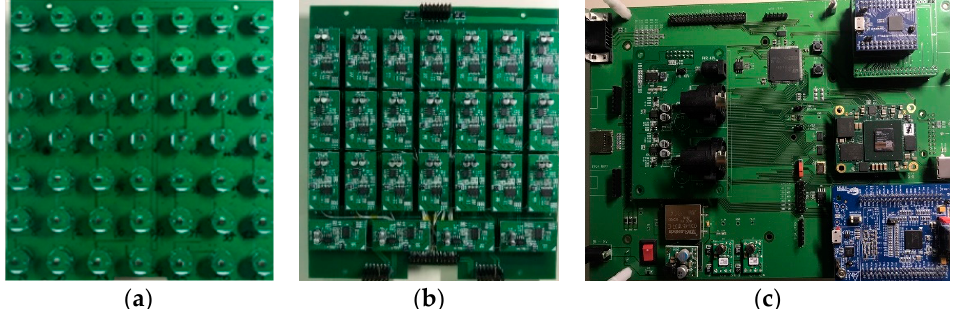
Figure 5. Implementation of the two-dimensional (2D) microelectromechanical system (MEMS) microphone array and the processor: ( a ) Arrangement of the MEMS microphone array, ( b ) A/D conversion modules, and ( c ) field programmable gate array (FPGA-) based controller for impulsive acoustic source localization.